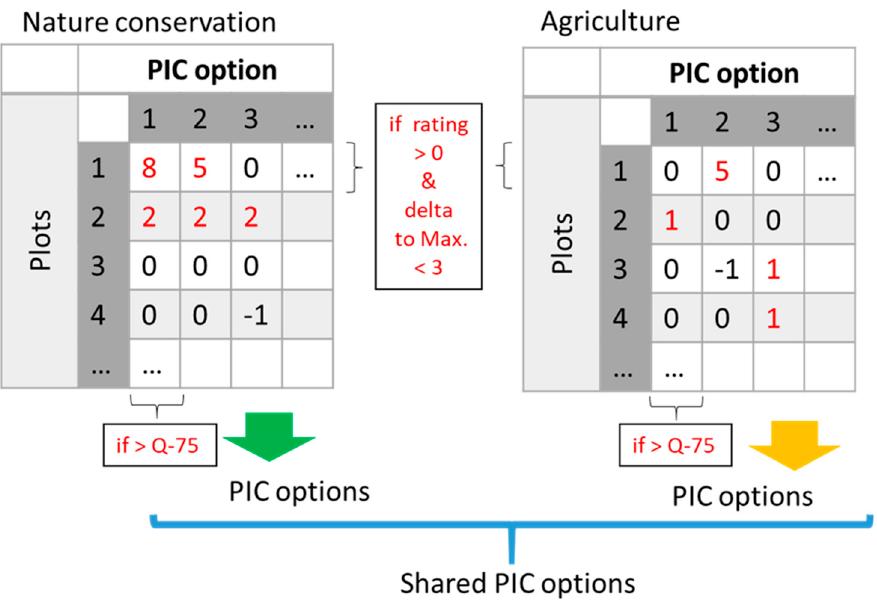
Figure 4. Derivation of plot-specific PIC option recommendations from a nature conservation and agricultural point of view based on the plot-specific overall assessment.